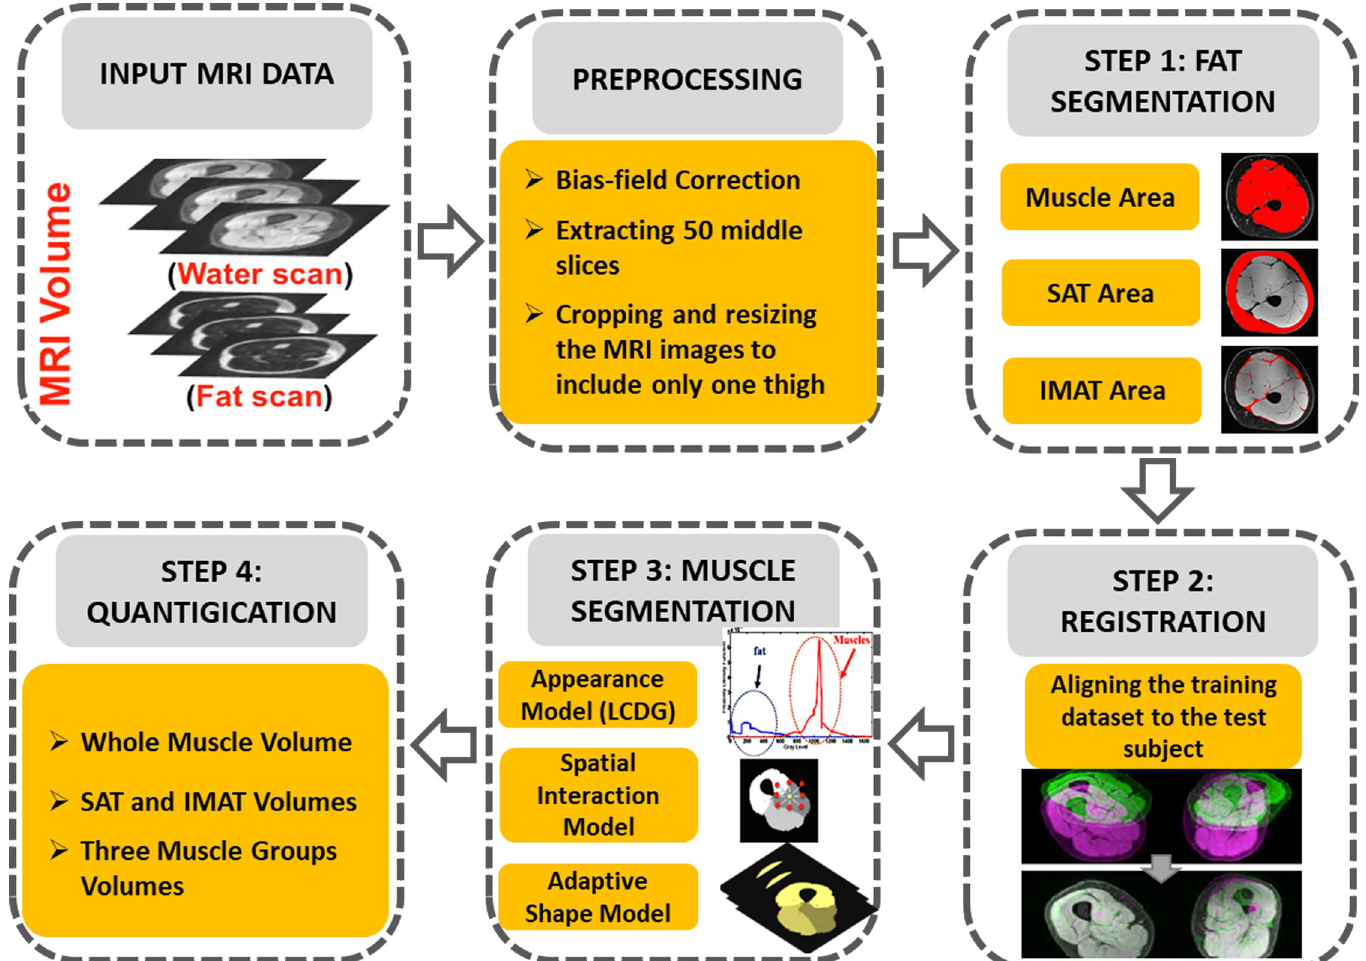
Fig 1. The proposed framework. The Block diagram of the proposed framework for muscles/fat segmentation and quantification based on MRI 3-D volumes.